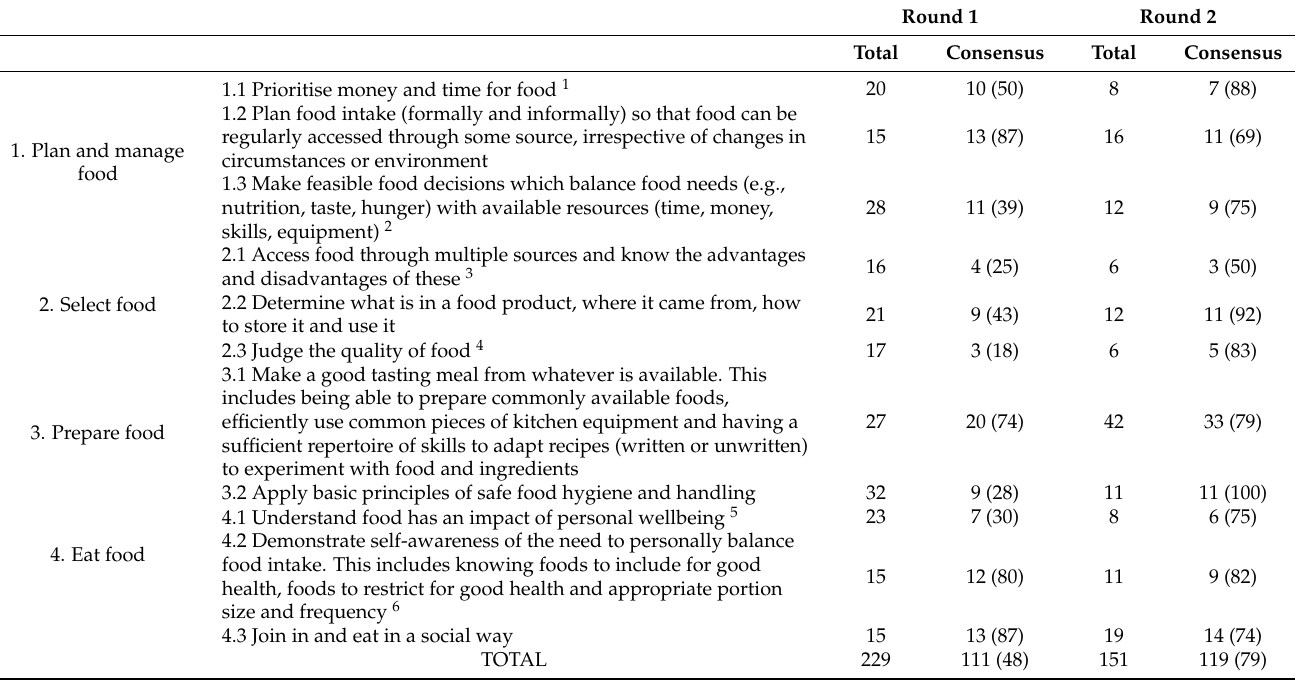
Table 2. The total number of items presented under each food literacy component in Round One and Round Two Surveys and the number (%) achieving consensus i.e., CVI score ≥ 0.71. (CVI scores of individual items is presented in the Supplementary